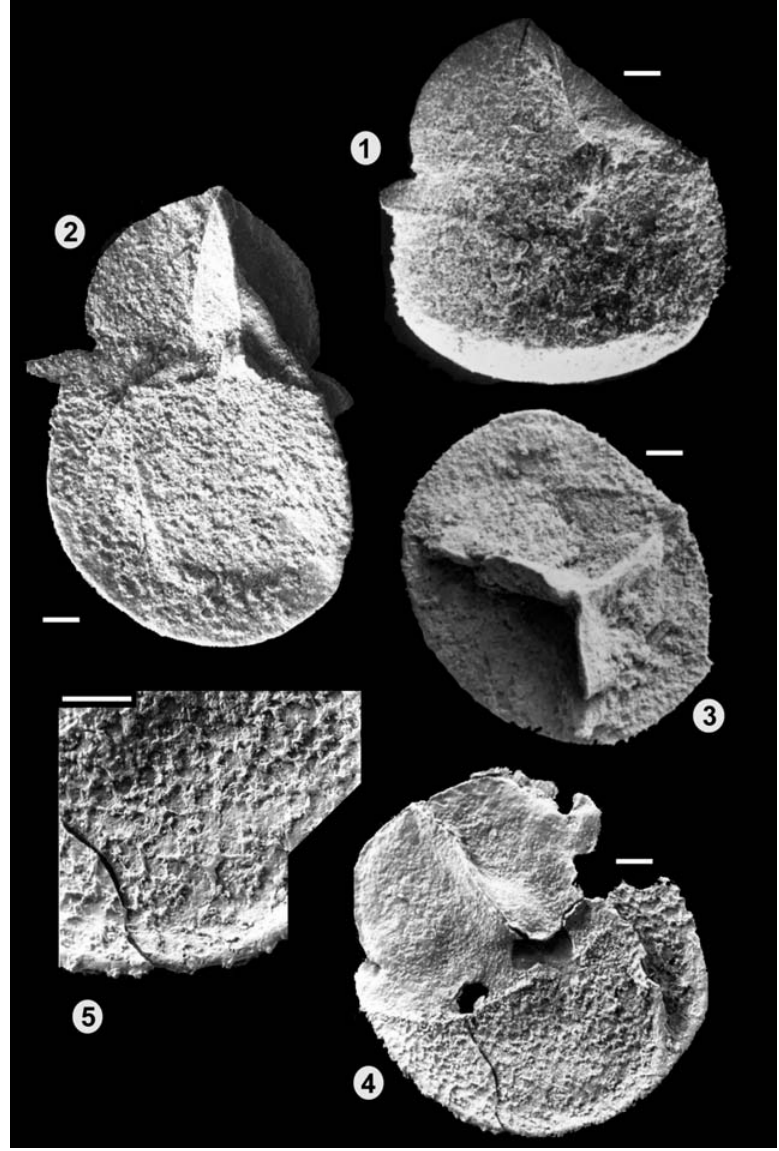
Fig. 3 – Megaspores Lagenoisporites triunfensis : 1. Lateral compression (GP/3T 2160b); 2. Distal-lateral compression (GP/3T 2160b); 3. Polar compression, proximal view (GP/3T 2165); 4. Lateral compression (GP/3T 2160b); 5. Magnification of fig. 4 showing orna- mentation. Scale bar = 200 µ